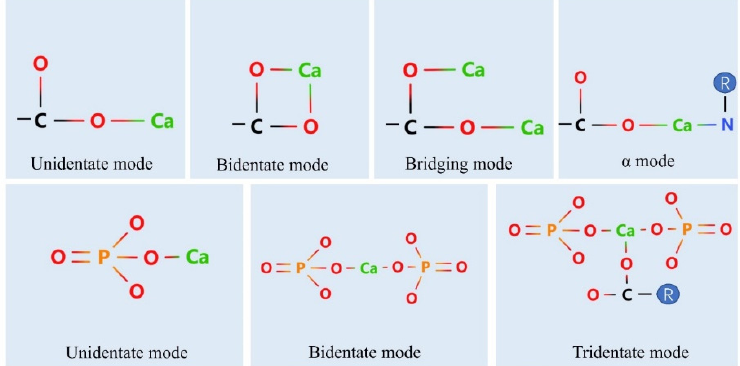
Figure 1. Binding modes of calcium ions to active sites.